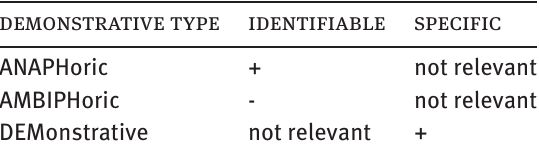
Table 1: Discourse properties of demonstrative pronouns in nominal constructions (the labels ‘anaphoric’, ‘ambiphoric’ and ‘demonstrative’ are adopted from Rumsey,